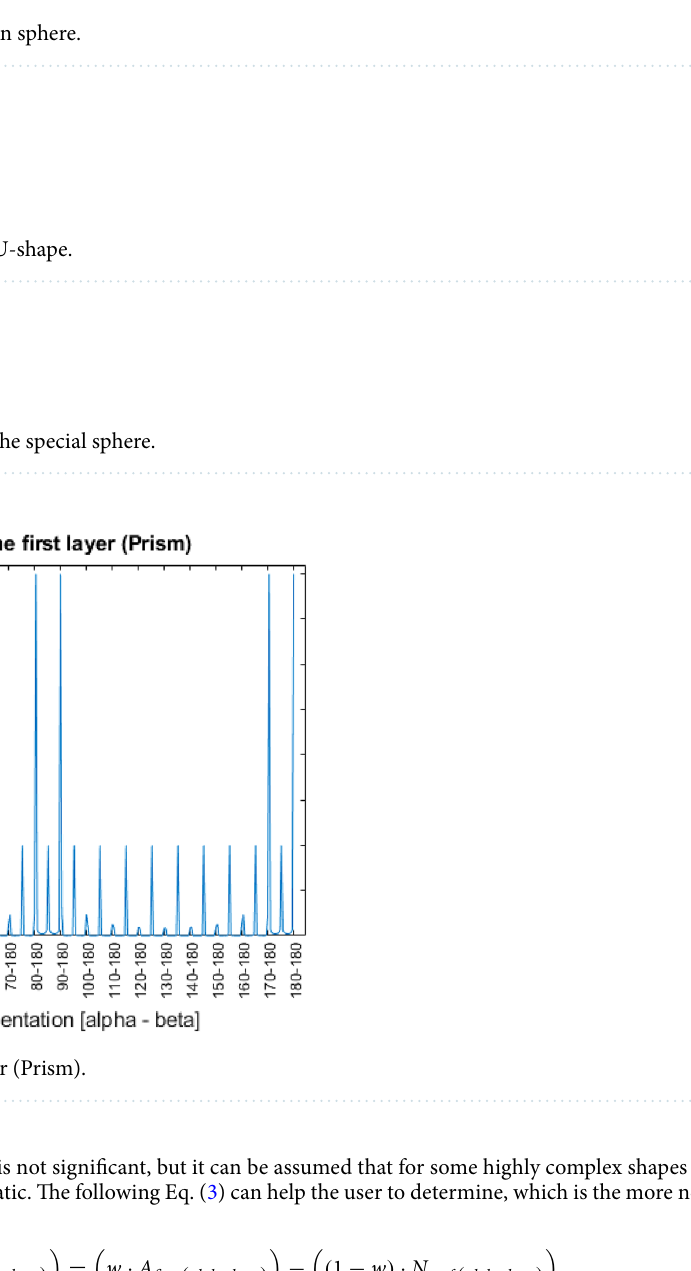
Table 3. Number of surfaces in sphere.